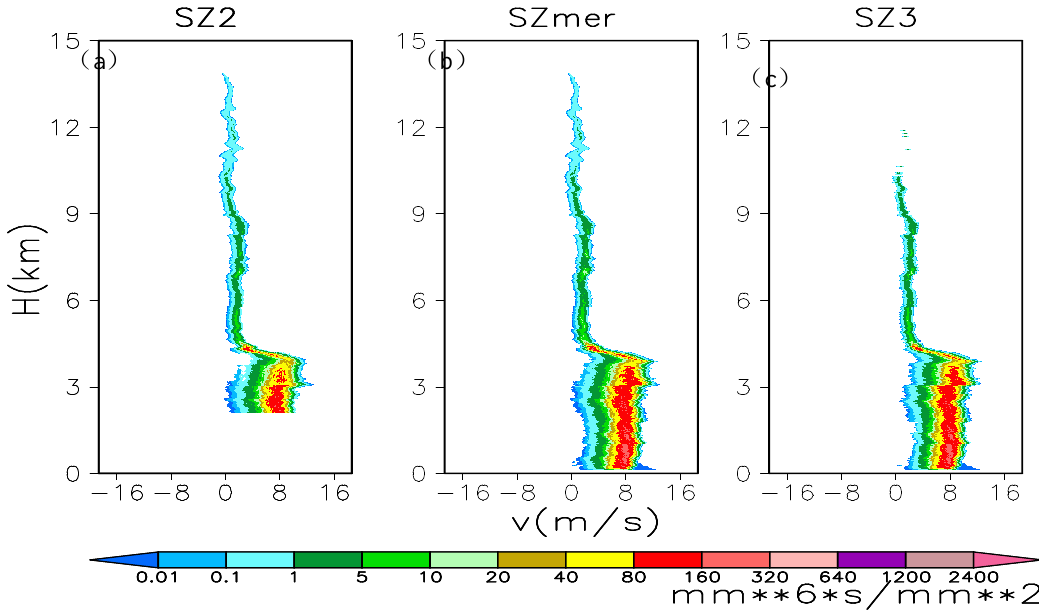
Figure 8. ( a ) SZ2 after artefact removal; merged reflectivity spectra of ( b ) SZm, and ( c ) SZ3.